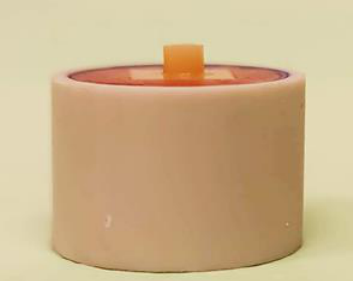
Figure 2. Representative image of a bonded specimen before testing.